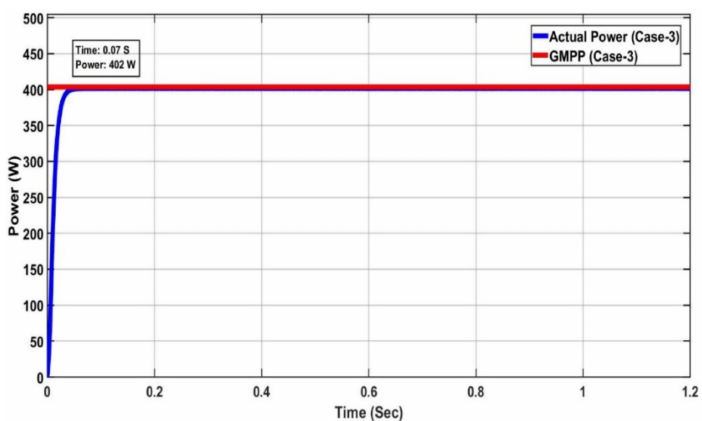
Figure 32. I-V curve (Case-3).